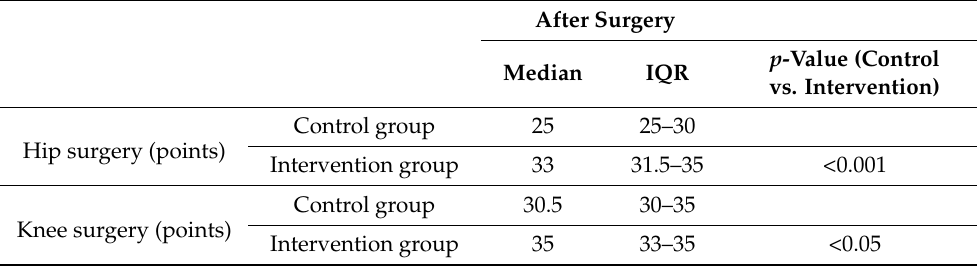
Table 3. Oxford Hip and Knee Score among hip and knee endoprosthesis patients. Data after hip and knee surgery are shown for the control and intervention groups,